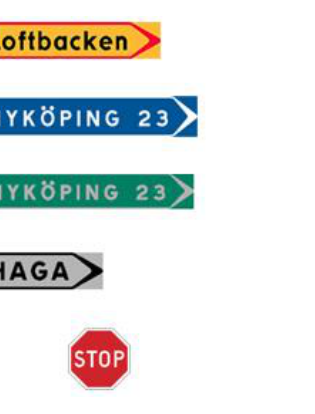
Figure 2. Randomly selected road signs in VTI data.